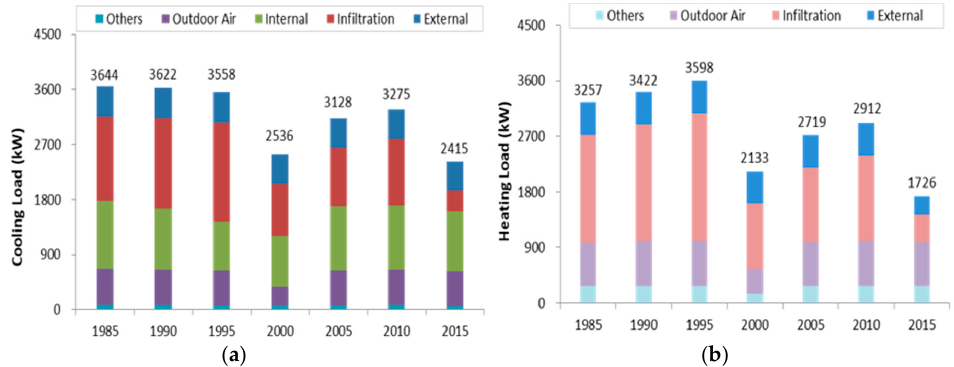
Figure 8. The result of the internal load per scenario.